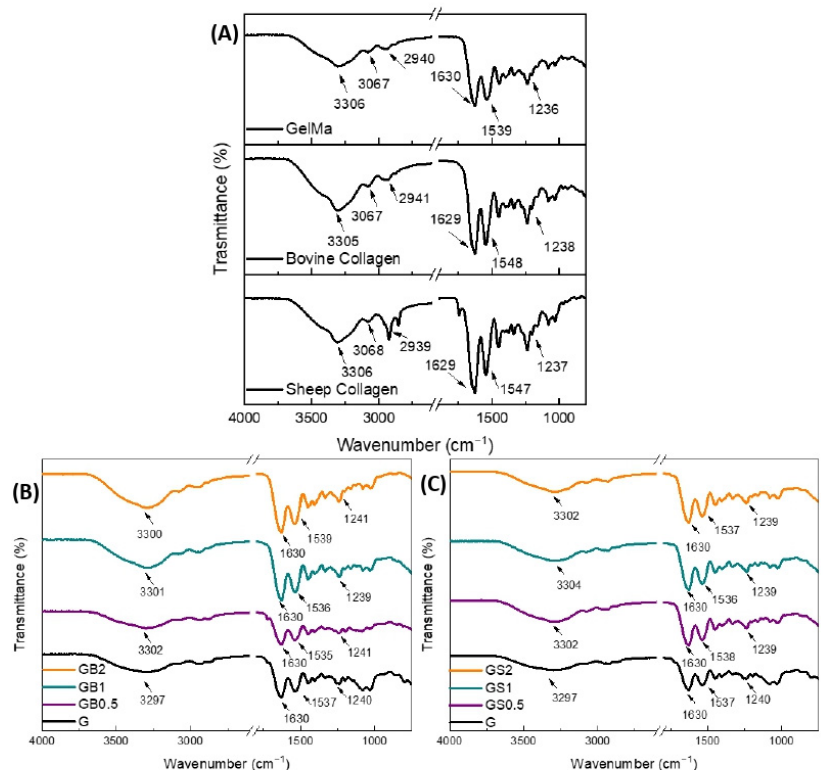
Figure 4. FTIR spectra of ( A ) the individual components, ( B ) the GelMA meshes containing 0.5%, 1%, and 2% bovine collagen compared with GelMA meshes, and ( C ) the GelMA meshes containing 0.5%, 1%, and 2% ovine (sheep) collagen compared with GelMA meshes.